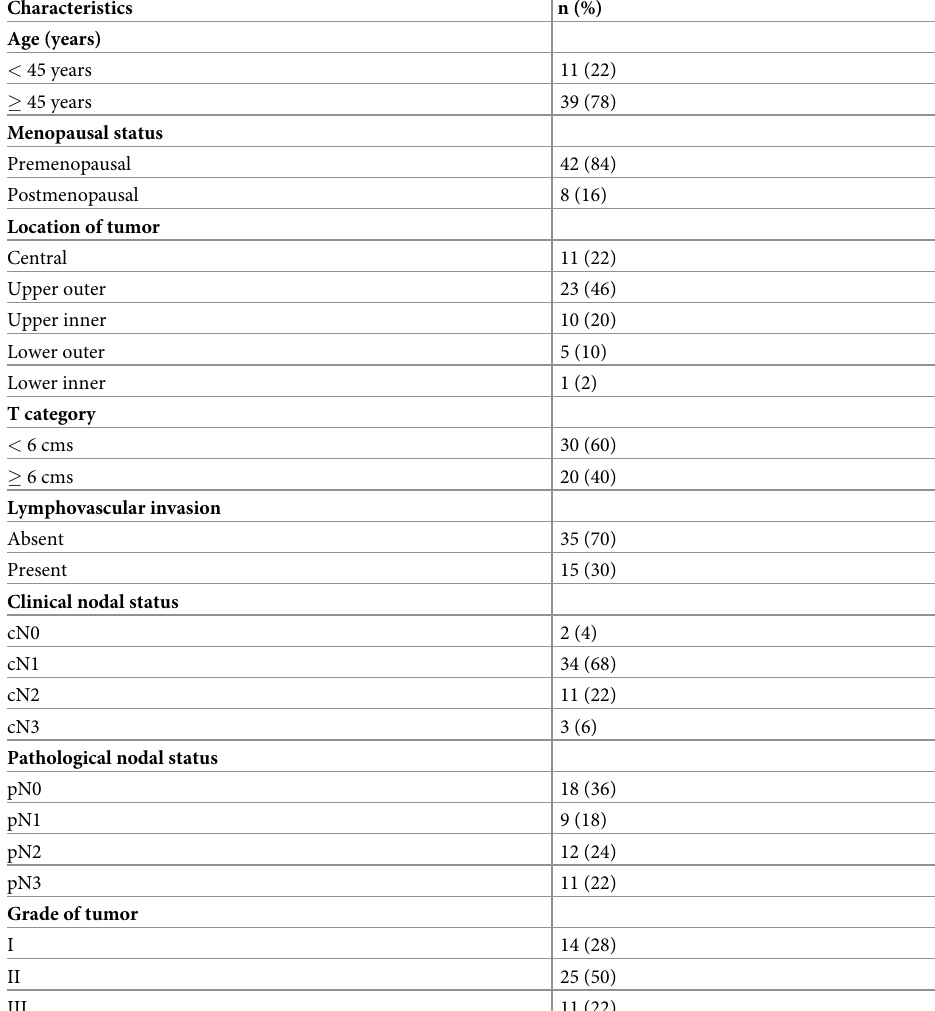
Table 1. Demographic and tumor profile of 50 patients with locally advanced